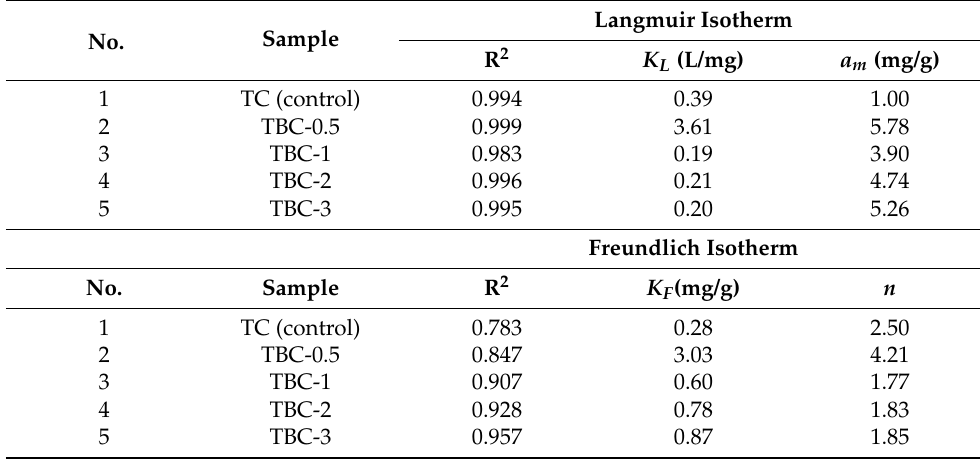
Table 4. Isotherm parameters for adsorption of MB from water